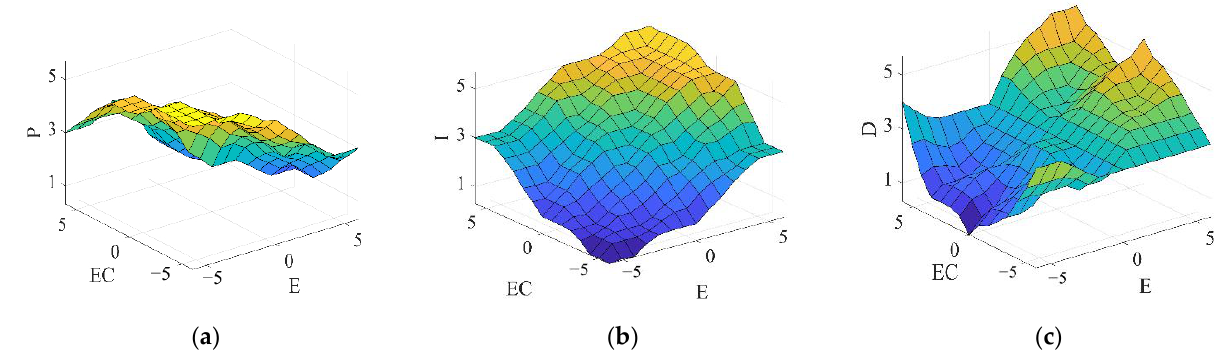
Figure 6. Schematic diagram of fuzzy rules: ( a ) fuzzy rule diagram of Δ k p ; ( b ) fuzzy rule diagram of Δ k i ; ( c ) fuzzy rule diagram of Δ k d .